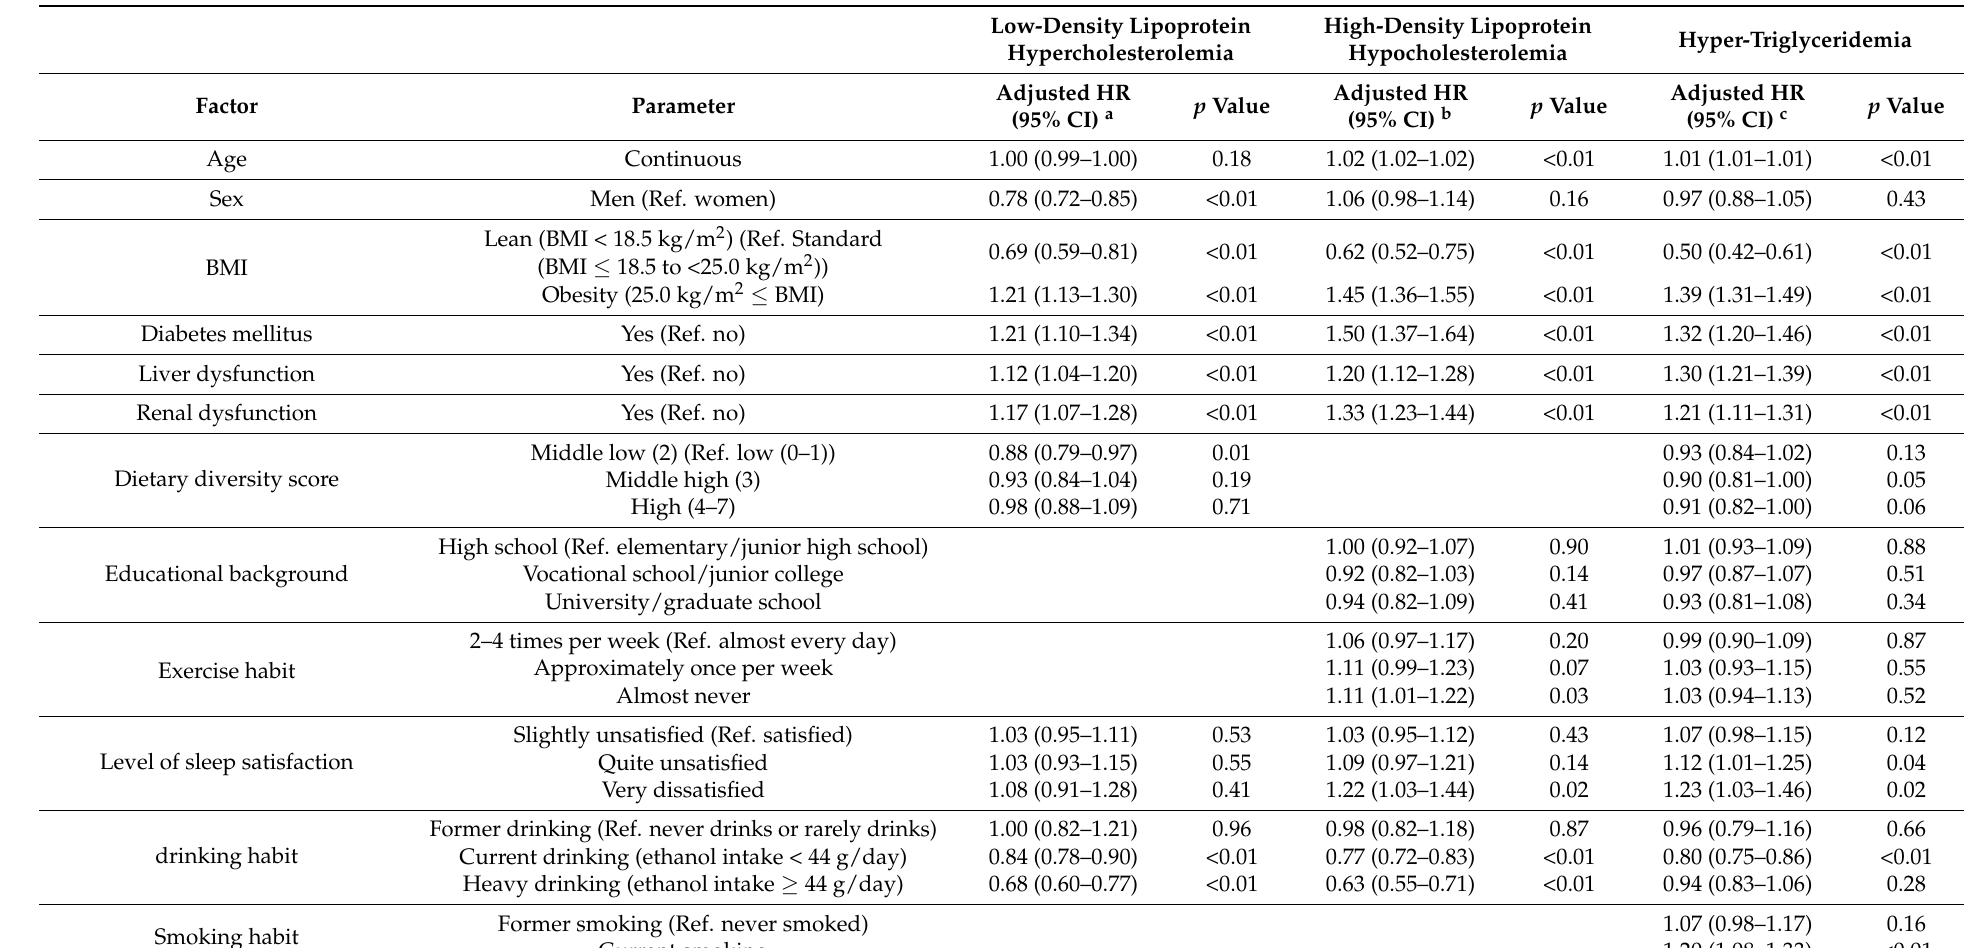
Table 4. Results of the multivariate Cox regression